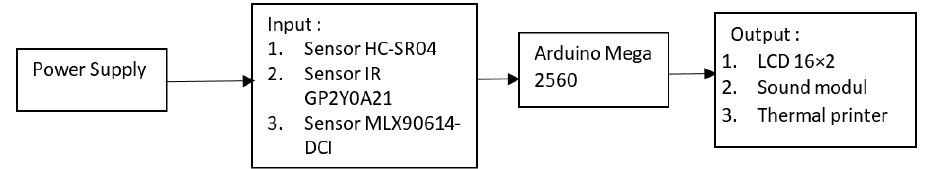
Figure 1. The block diagram of the anthropometric system is consisted of the input components, namely the ultrasonic sensor HC-SR04, the half-bridge type load cell sensor, the temperature sensor, a microcontroller component, the Arduino Mega 2560, and the output component consists of an LCD to display measurement data.